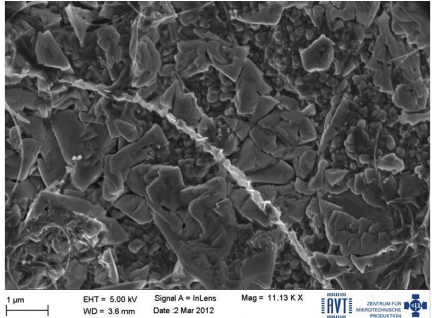
Figure 4: SEM Image of copper grains adhered to a carbon nan-